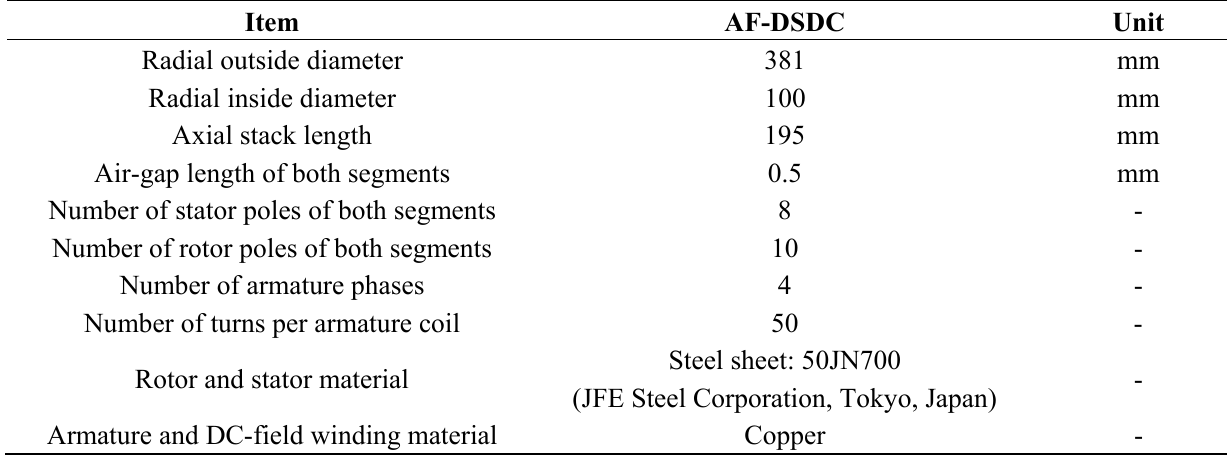
Table 2. Key data of proposed machine.